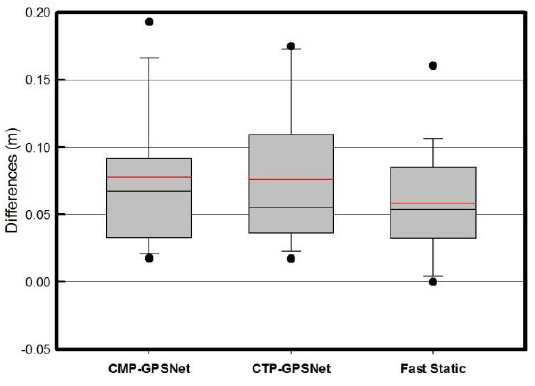
Figure 6. 3D Differences between CMP-GPSNet, CTP- GPSNet and Fast Static with respect to